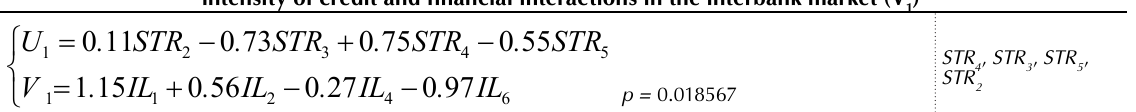
Indicators for assessing the SIB activity (U Indicators for assessing the intensity of credit and financial interactions in the interbank market (U